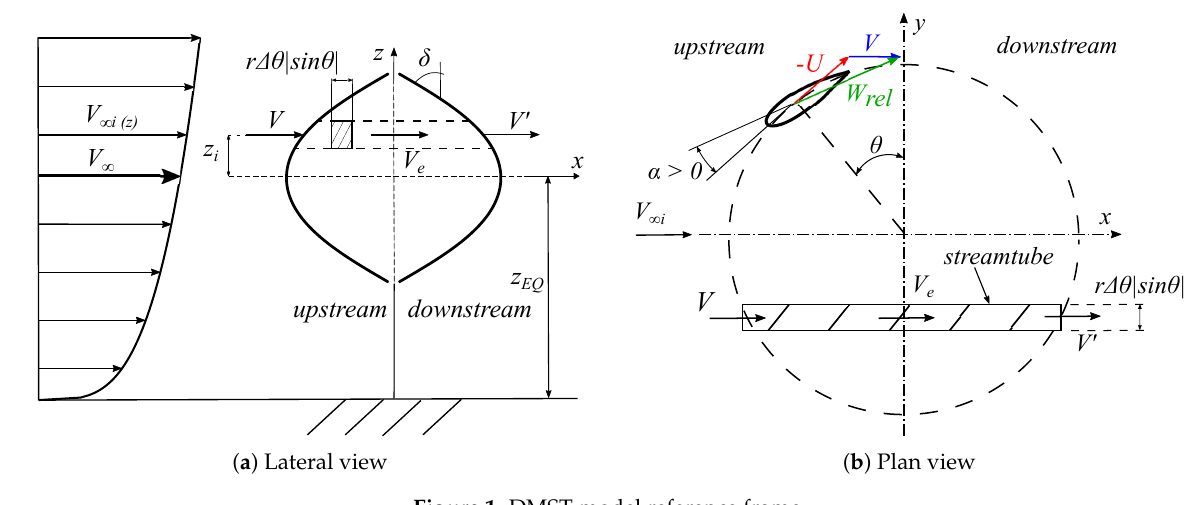
Figure 1. DMST model reference frame.